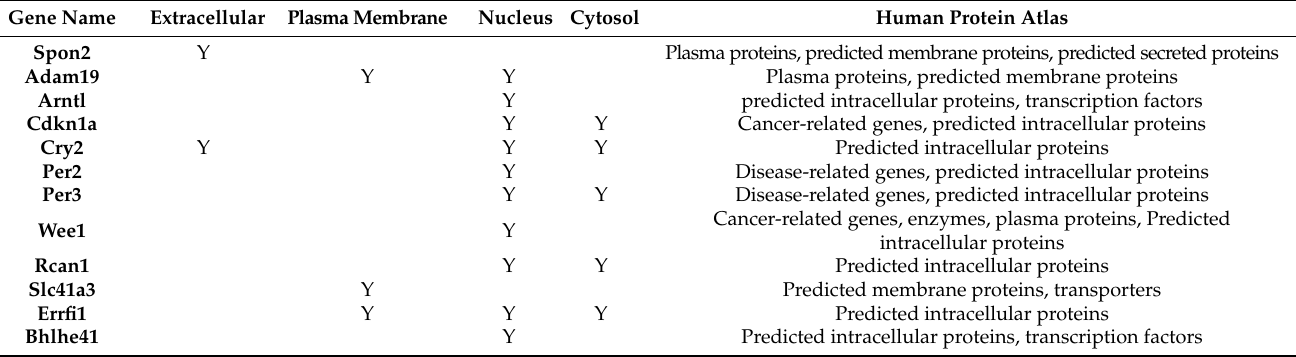
Table 3. Cellular localization of 12 overlapping differentially expressed genes.